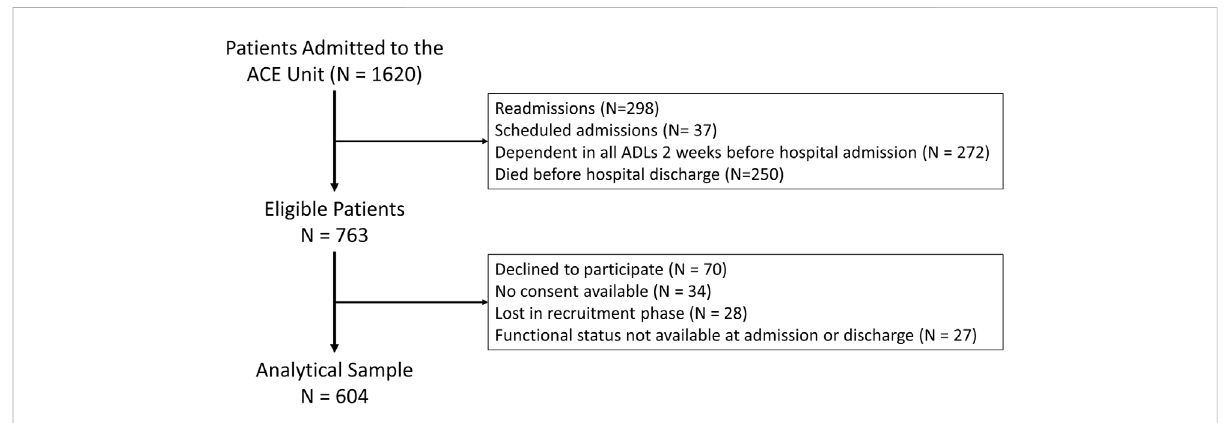
FIGURE 1 Flow-Chart. Derivation of the study